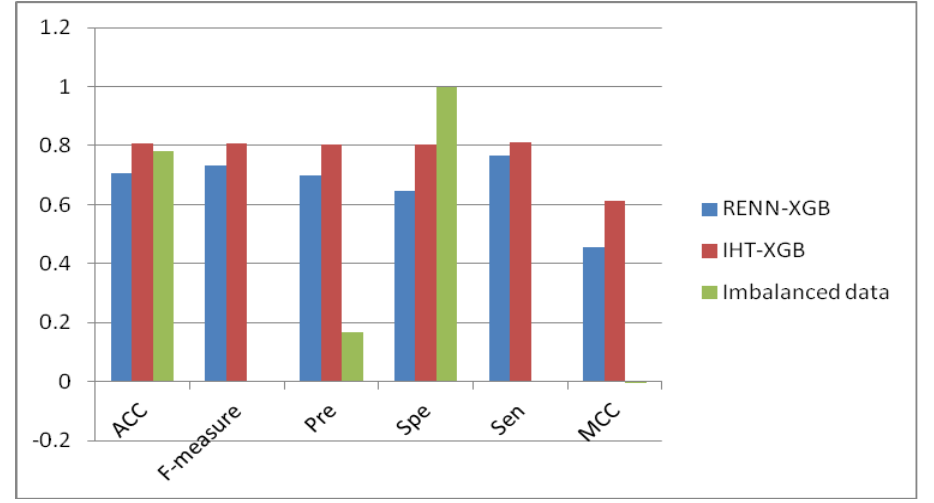
Figure 1. Performance comparison between the original and re-balanced datasets.